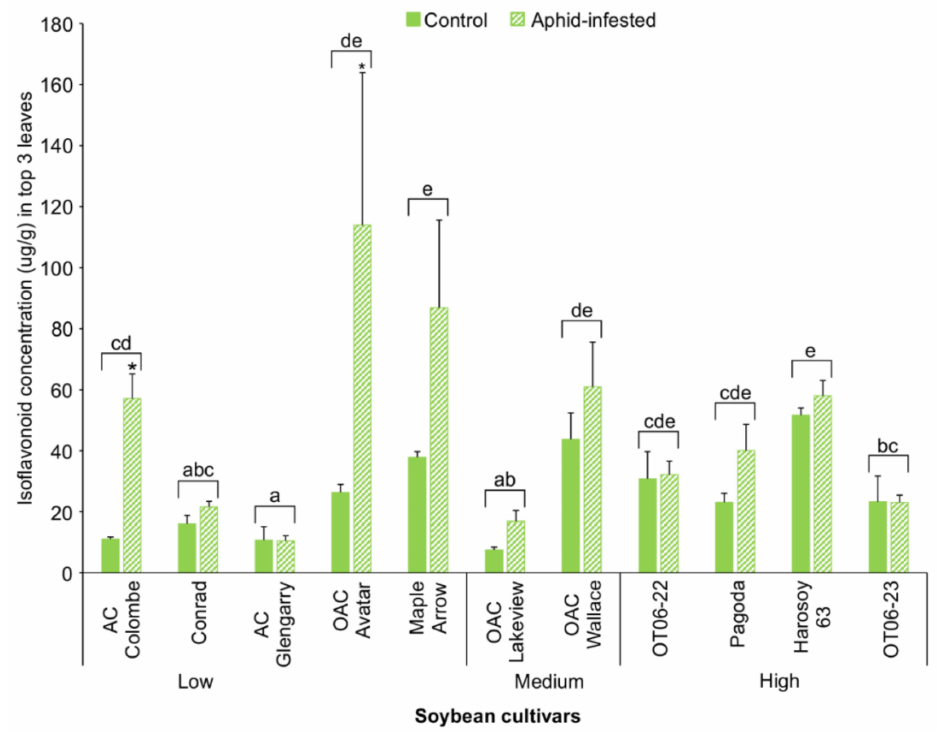
Figure 3. Mean isoflavonoid concentrations ( µ g/g; ± S.E.) in combined top three trifoliate leaves with and without aphids of 11 soybean cultivars after 4 weeks growth under greenhouse conditions. Bars with the same lowercase letters indicate no significant difference ( p > 0.05) for the isoflavonoid concentrations between those cultivars. Bars with an asterisk (*) indicate a significant difference ( p < 0.05) between the control and aphid-infested leaves for that